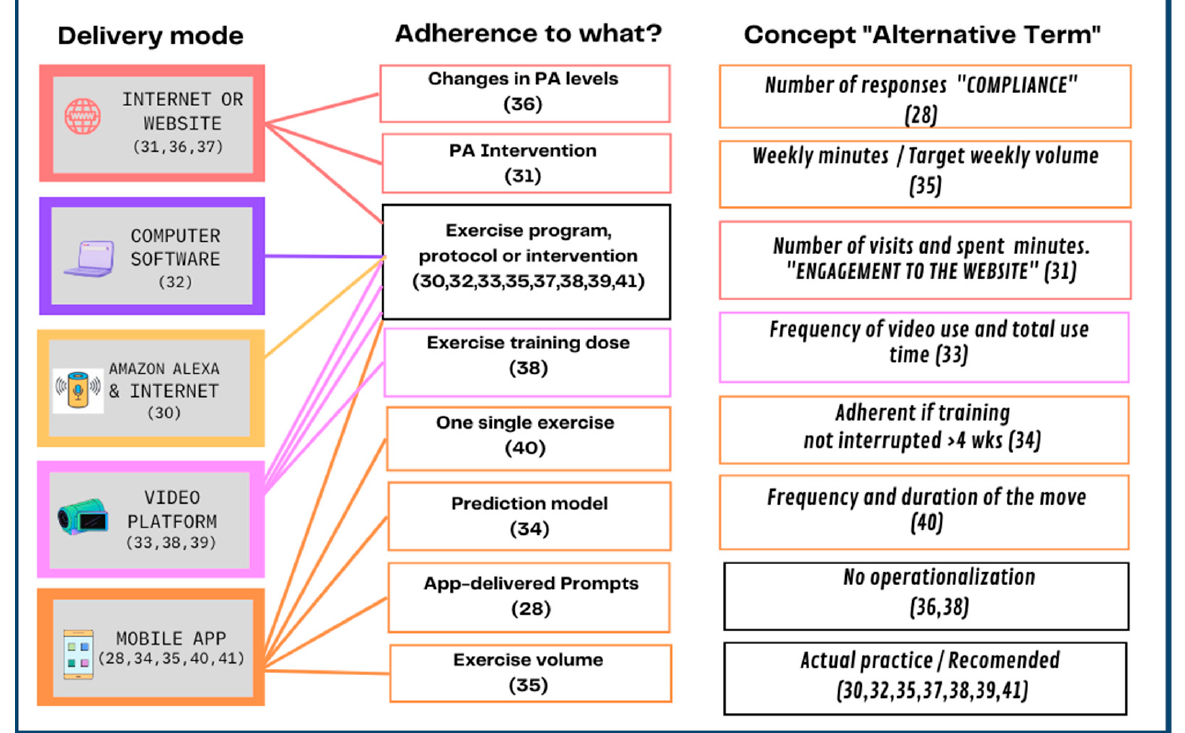
Figure 2. How has technology-delivered physical activity/exercise been defined in the literature [28,30–41].